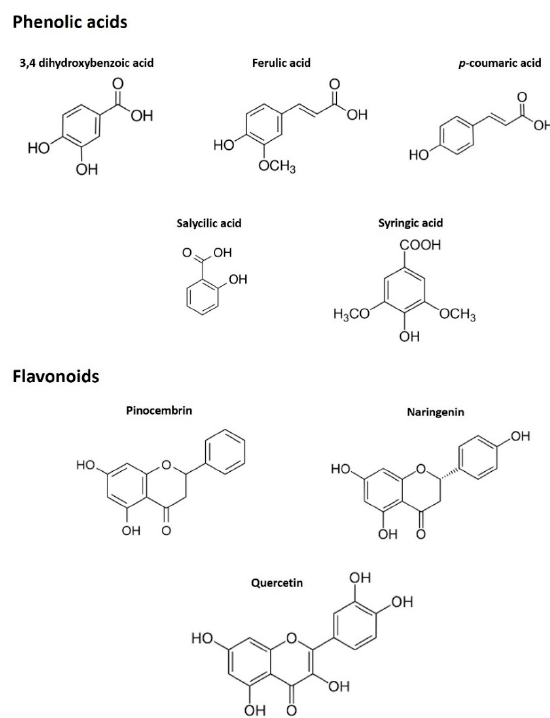
Figure 2. Chemical structures of the principal phenolic compounds detected by HPLC-ESI-MS/MS.